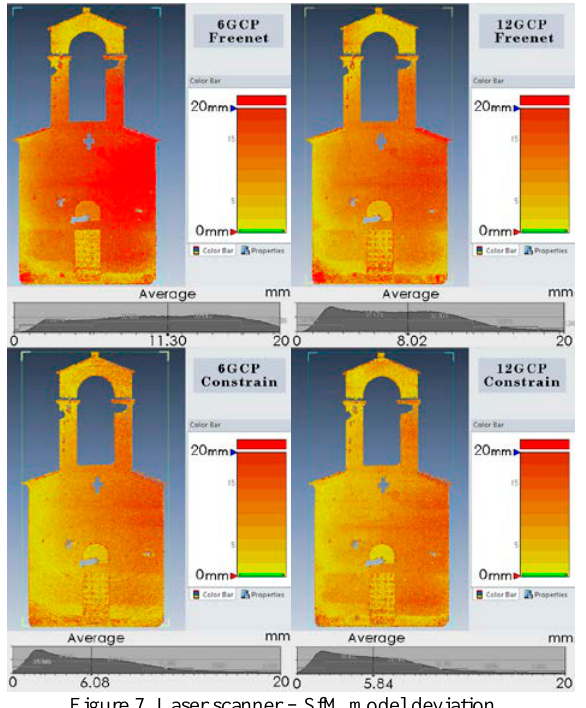
Figure 7. Laser scanner – SfM model deviation